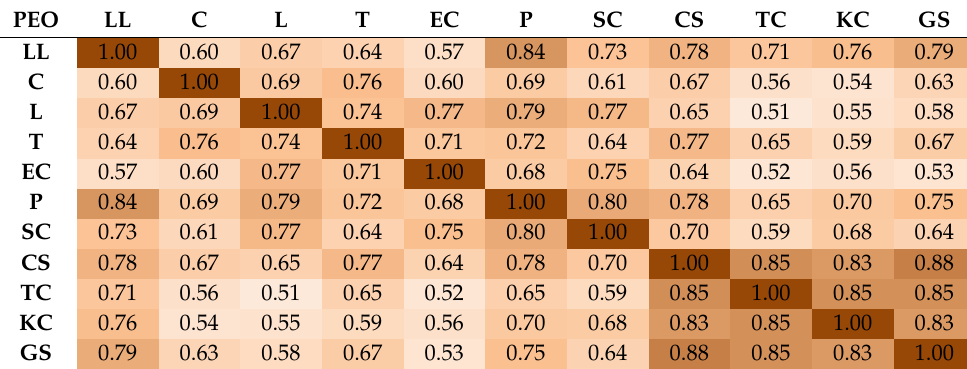
Table 10. Average similarity